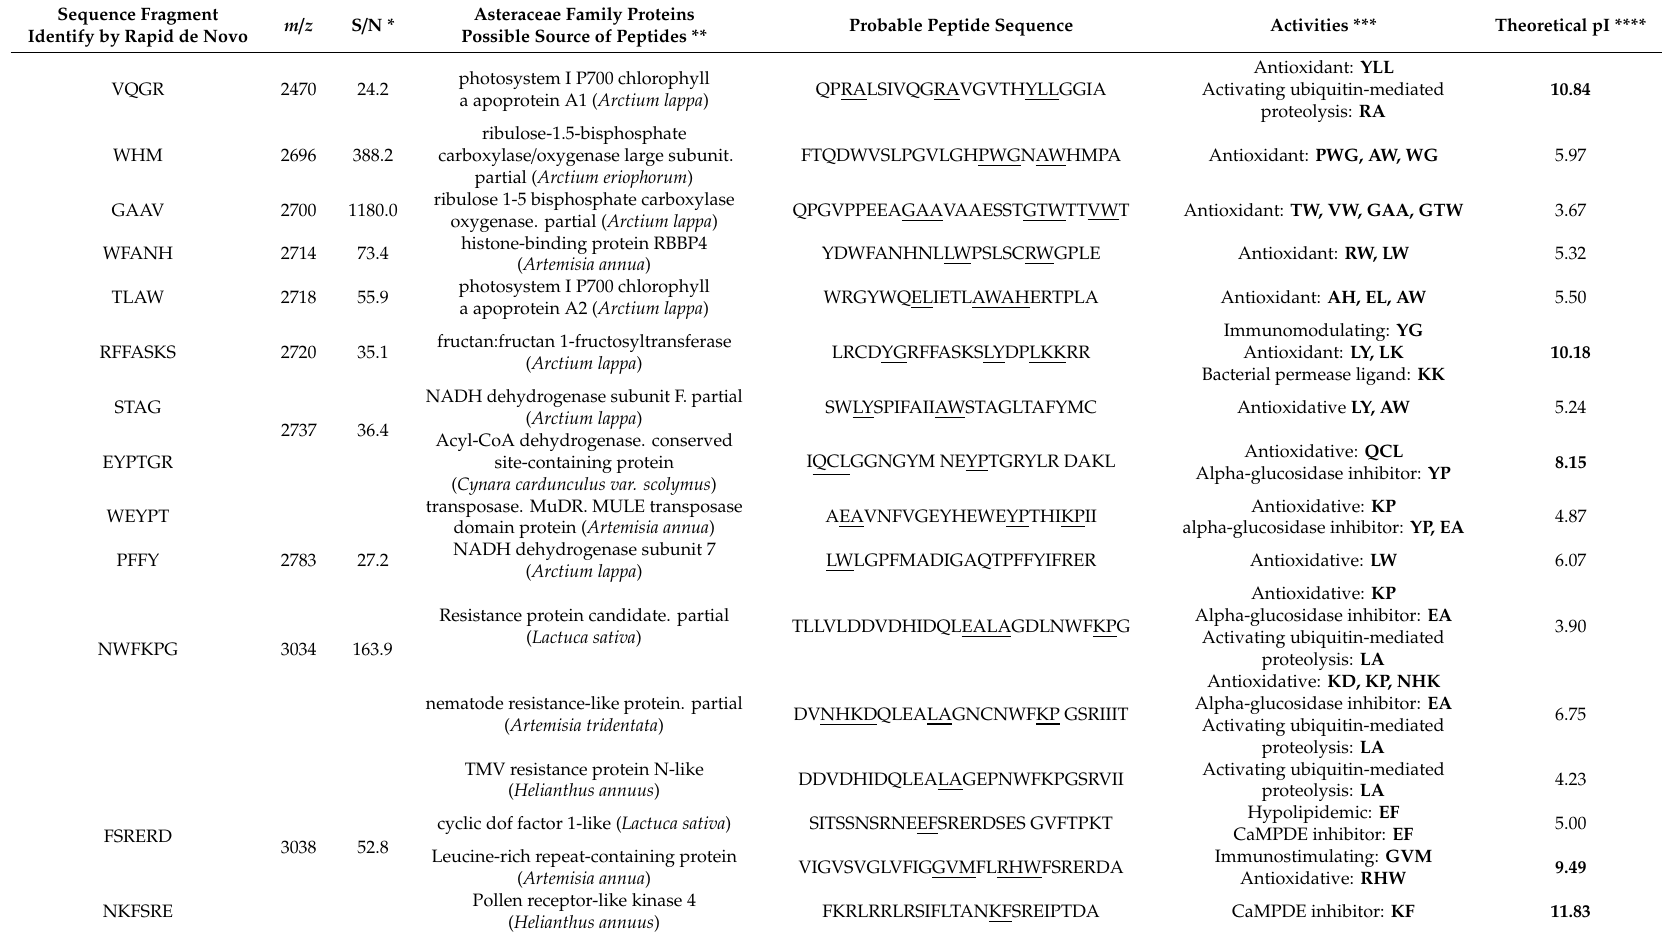
Table 2. Peptide Br-p sequence fragments assigned in RapidDeNovo sequencing; theoretical activity character and